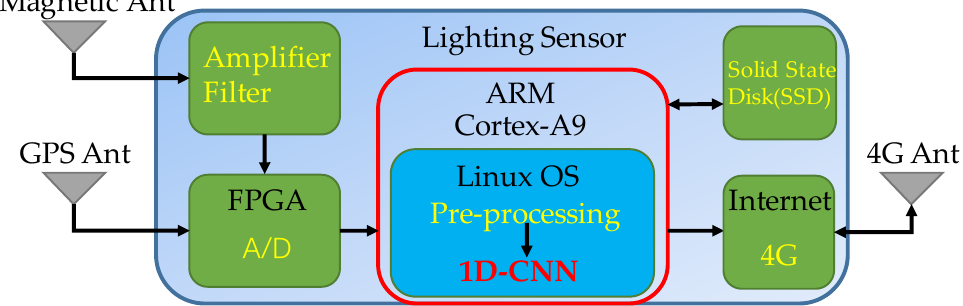
Figure 11. The system block diagram of the lightning sensor.